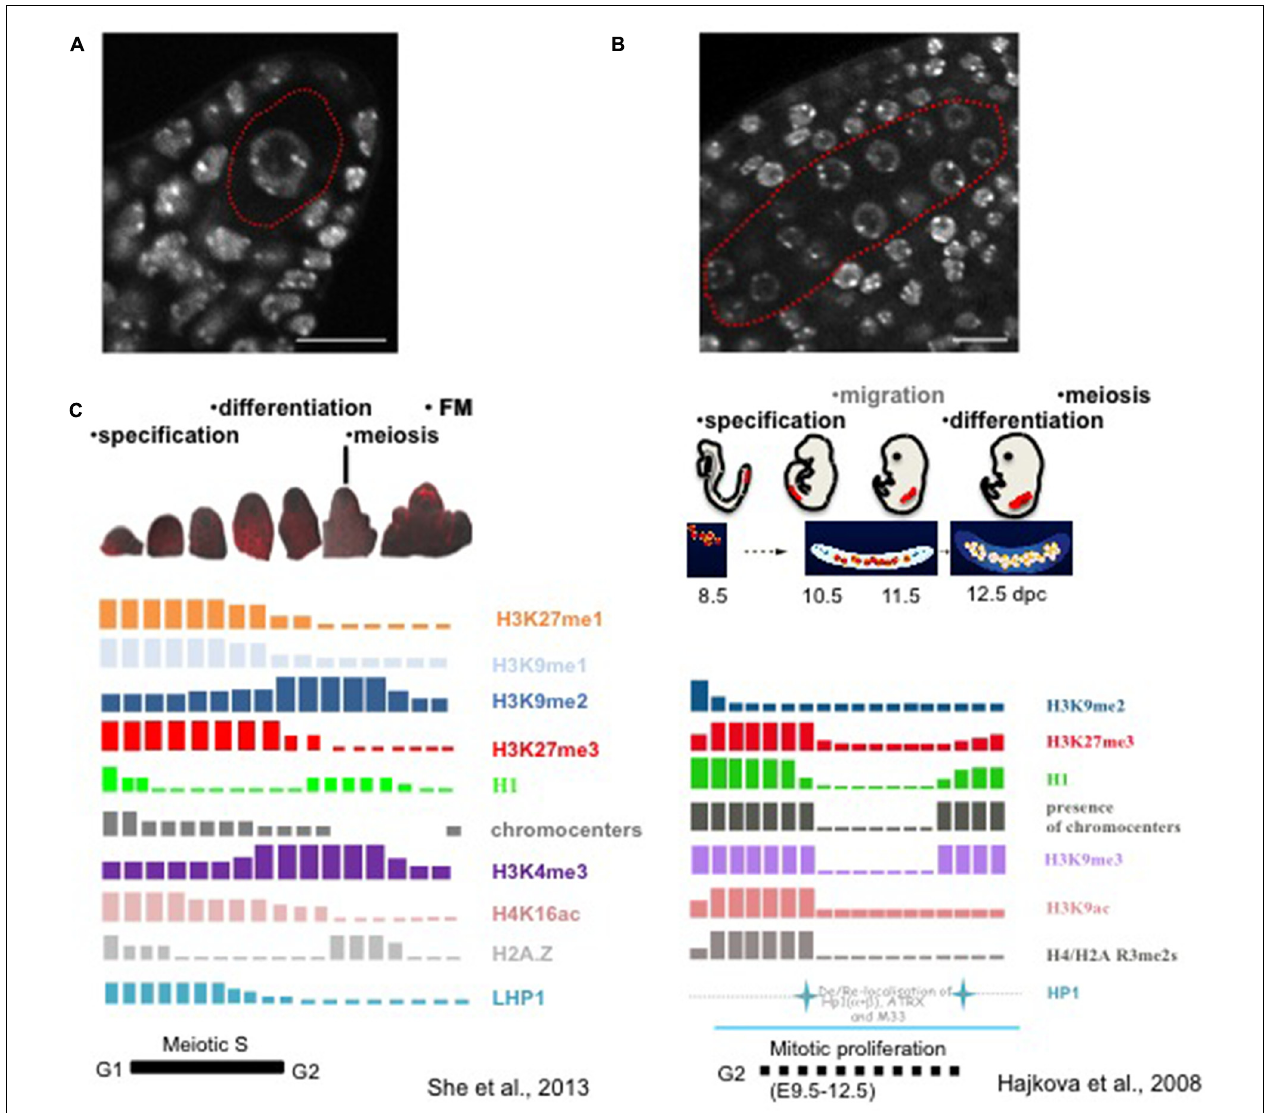
FIGURE 2 | Chromatin dynamics in plant MMCs shows similarities to that in animal PGCs. (A) The MMC (red contour) originates from a subepidermal somatic cell in the ovule primordium, it is distinct from the surrounding nucellar cells by its enlarged nuclear size, as shown by whole-mount DNA staining using propidium iodide of the early ovule primordium as described (She etal., 2013). Scale bar: 10 μ m. (B) Specification of PMCs (red contour) in the anther, which are marked by the enlarged nuclear and nucleolar size compared to the surrounding somatic cells.The anther was stained by propidium iodide in whole-mount as described for ovule primordia